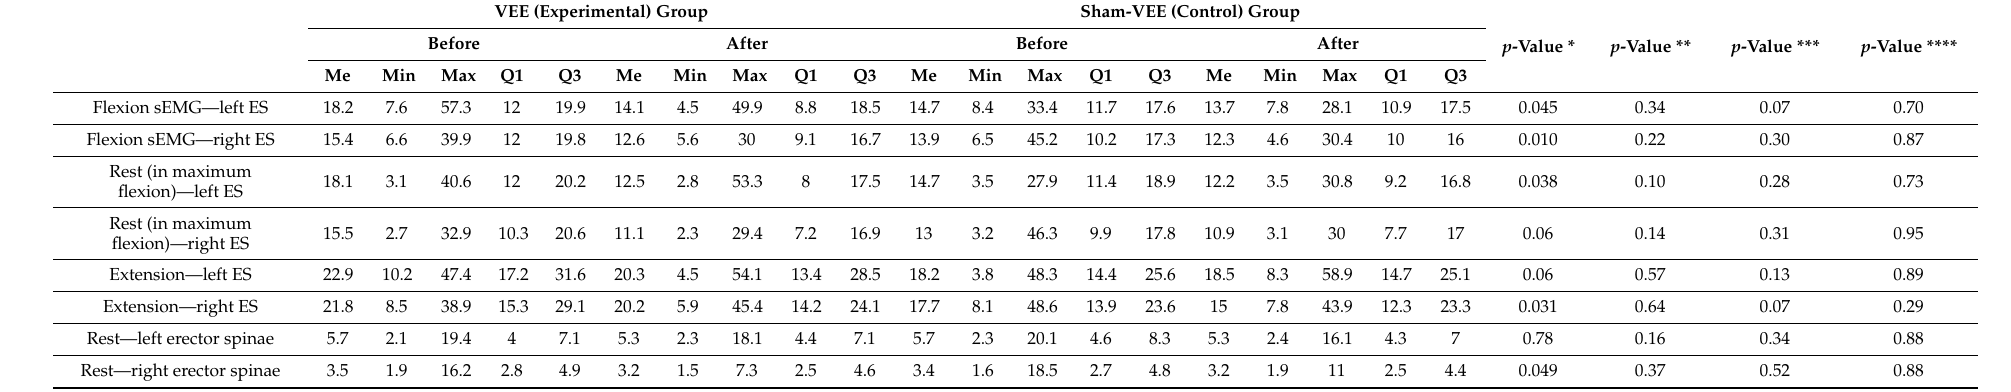
Table 2. Intragroup and intergroup comparisons of the changes in erector spinae sEMG measured before and after the PA intervention ( µ V).